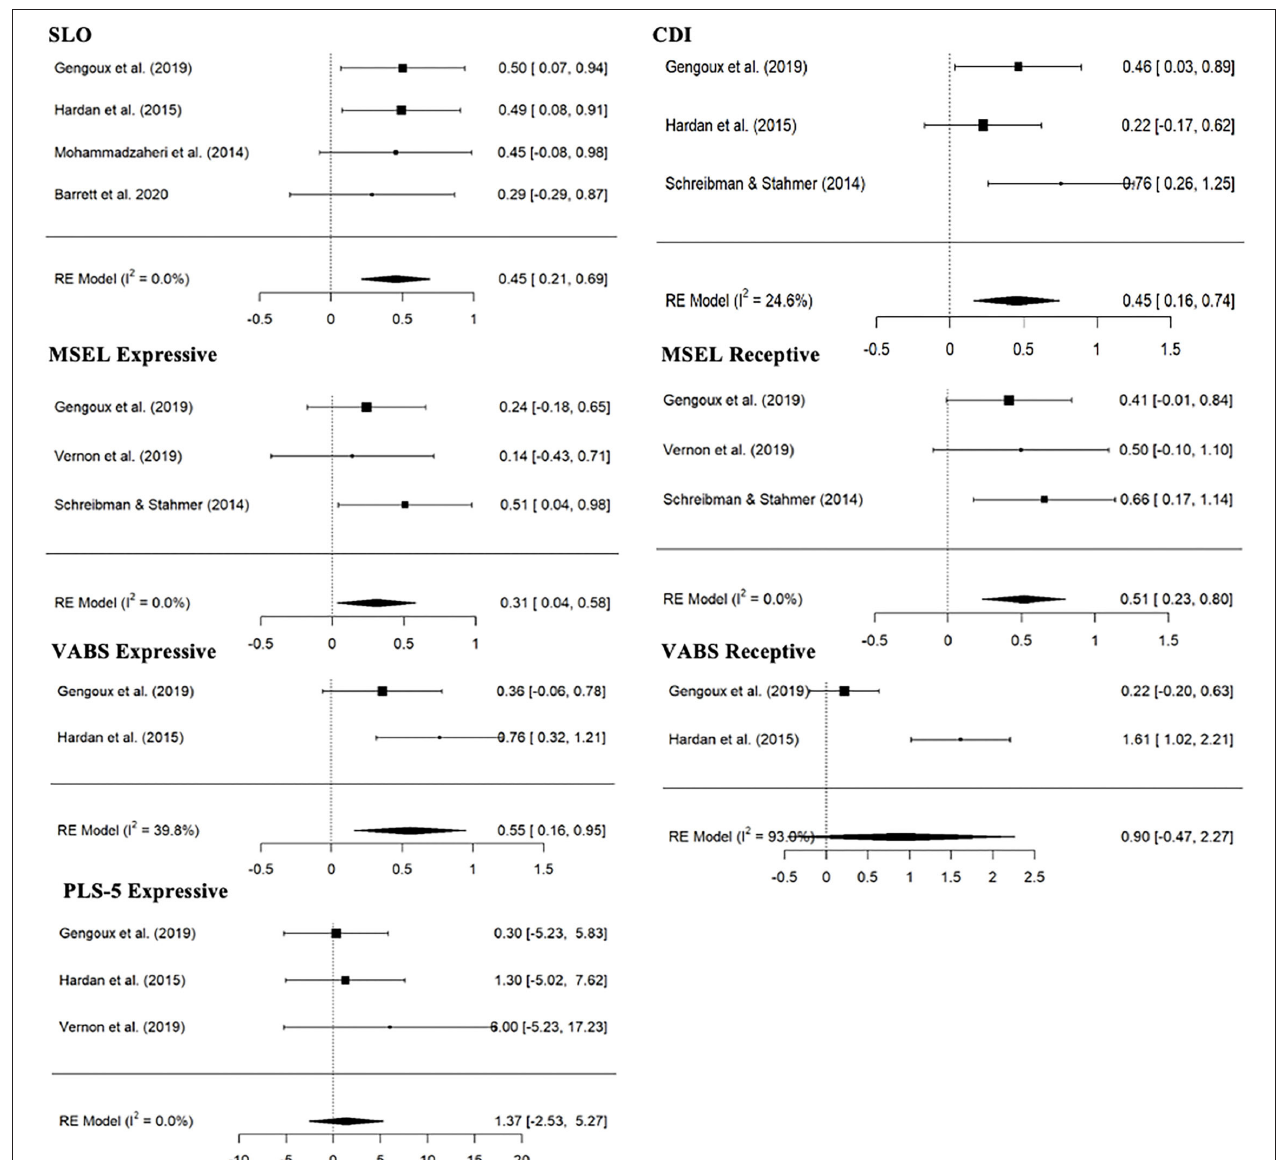
FIGURE 2 | Forest plot of estimates for PRT effects across communication measures. CDI, MacArthur-Bates Communicative Development Inventories; MSEL, Mullen Scales of Early Learning; PLS-5, Preschool Language Scale; SLO, structured laboratory observation; VABS, Vineland Adaptive Behavior Scales.